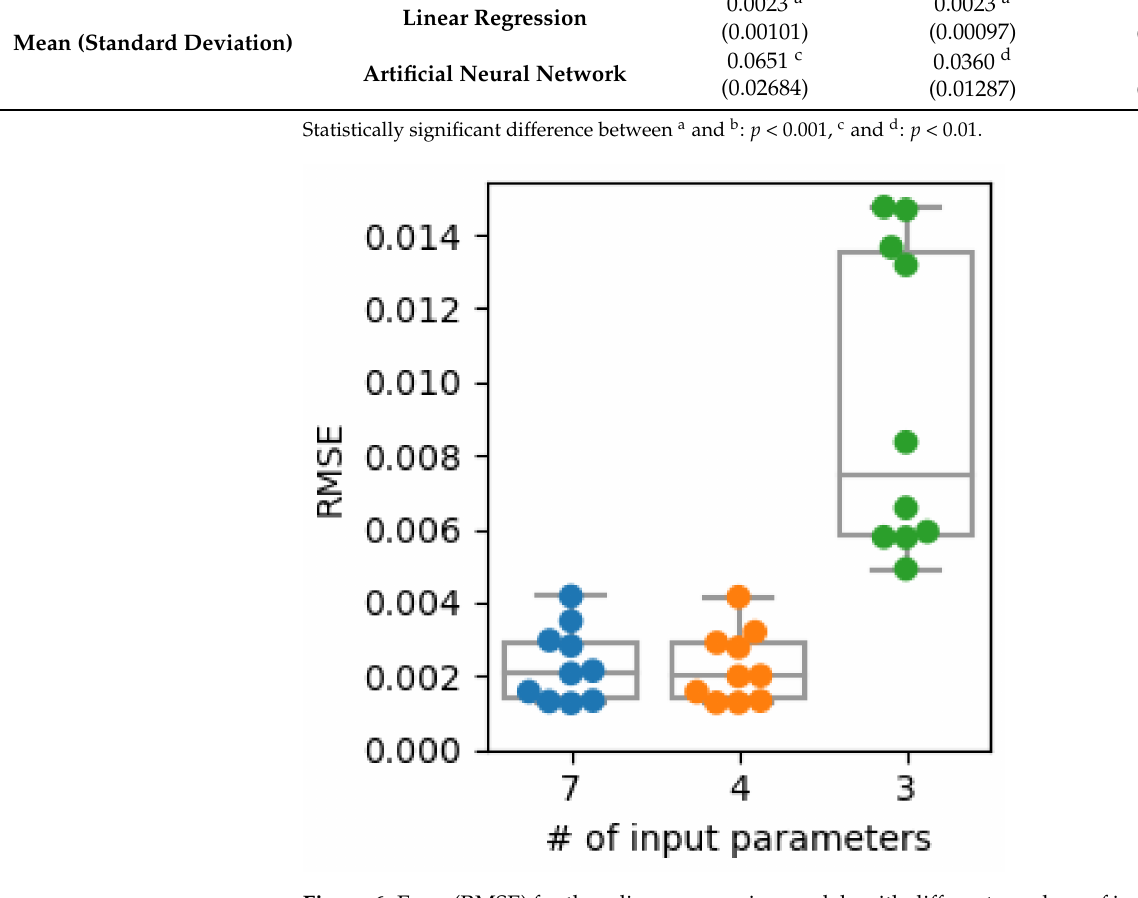
Figure 6. Error (RMSE) for three linear regression models with different numbers of input